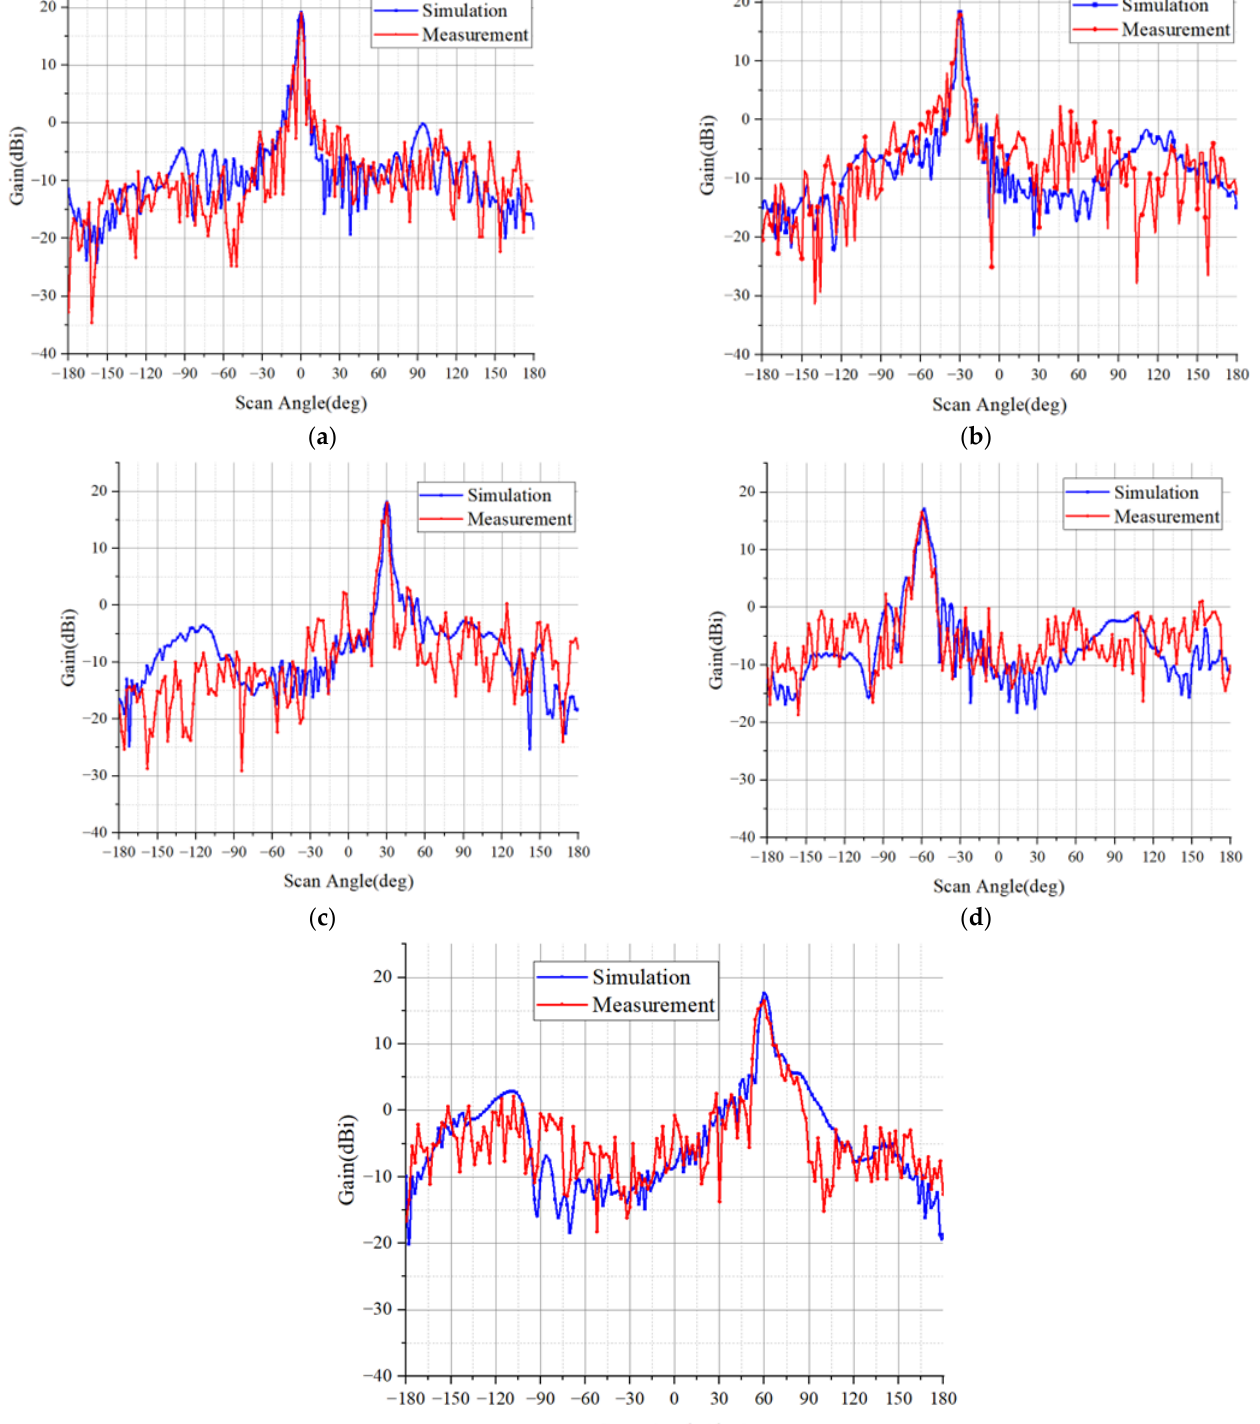
Figure 9. Simulated and measured results for different scan angles. ( a ) φ = 0 °. ( b ) φ = − 30°. ( c ) φ = 30°. ( d ) φ = − 60°. ( e ) φ = 60°.